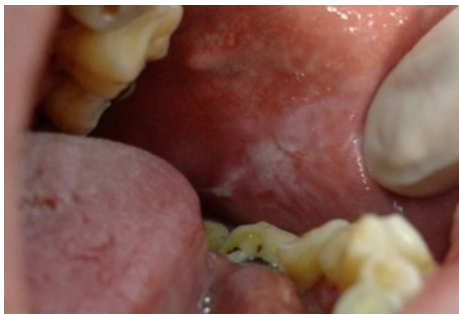
Figure 5. Morsicatio buccarum on the left buccal mucosa of a teenage boy. In this patient, the lesion was observed bilaterally in an atypical location in the midpart of the buccal mucosa along with occlusal line. The mucosa is white, thickened, shredded, and combined with zones of the erythema and erosion.